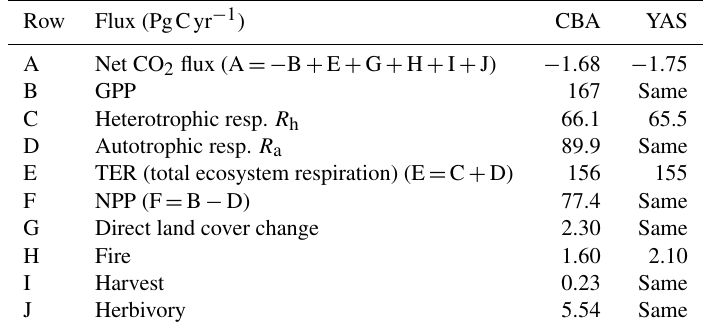
Table 2. Global terrestrial C fluxes from the two different model formulations averaged over 2001–2014. Row